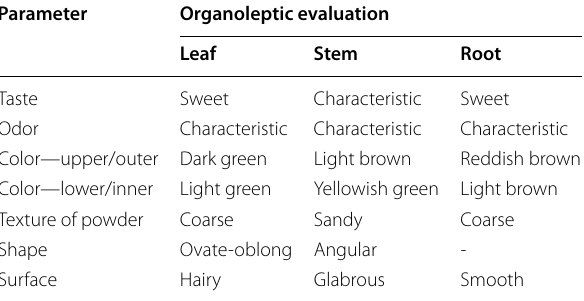
Table 2 Organoleptic studies of D. gangeticum Parameter Organoleptic